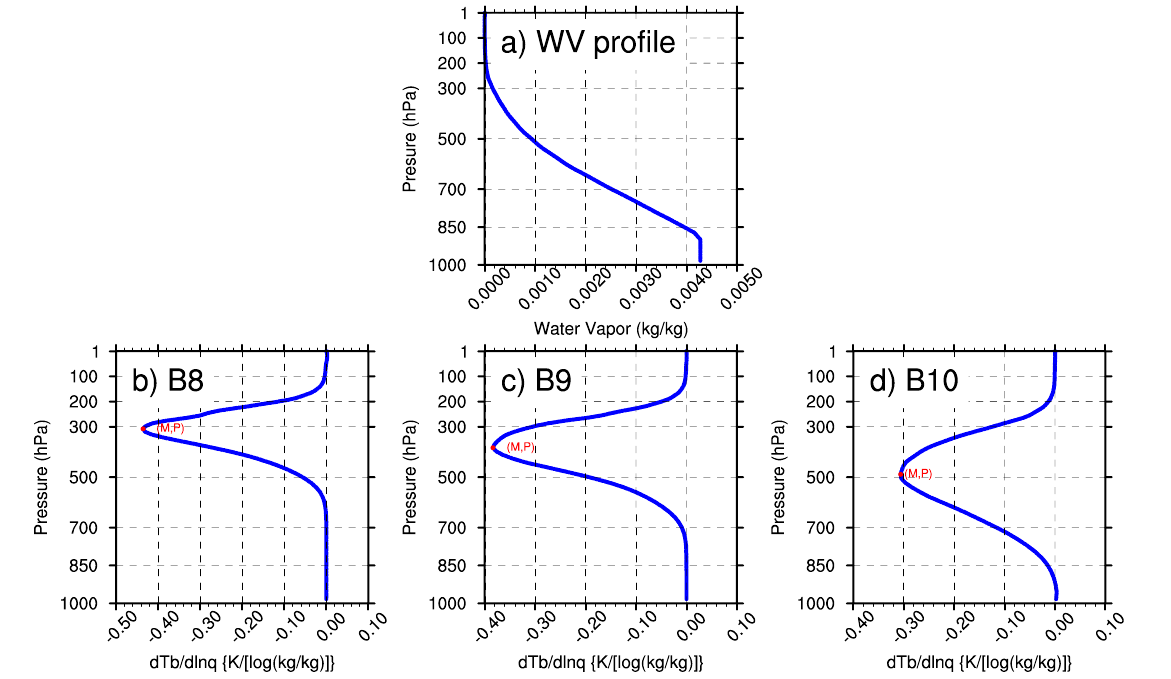
Figure 3. ( a ) The water vapor profile of the U.S. standard atmosphere. ( b )–( d ) The calculated Jacobian function of Band 8, Band 9 and Band 10, respectively.